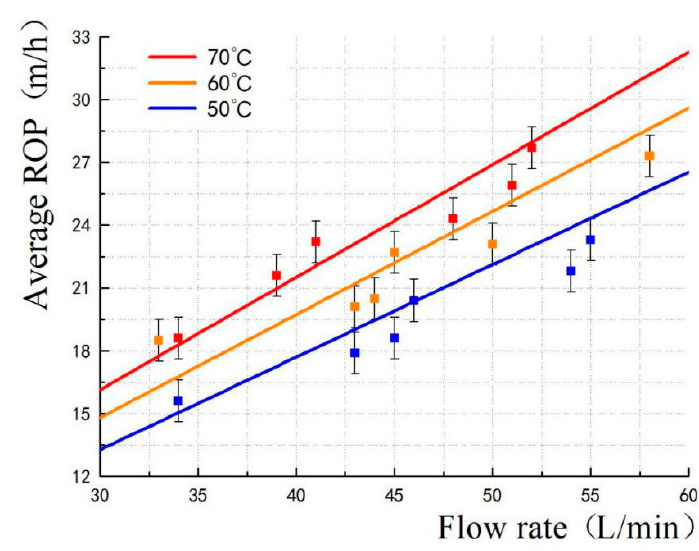
Figure 11. The comparison between experimental and theoretical data. The lines were drawn using Equation (8).